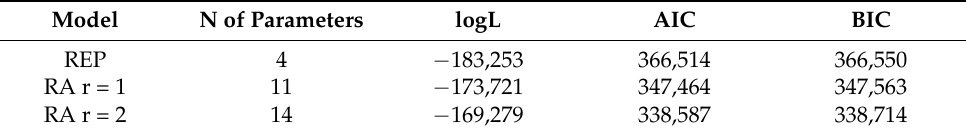
Table 3. Comparison among repeatability (REP) and random regression models (RA).